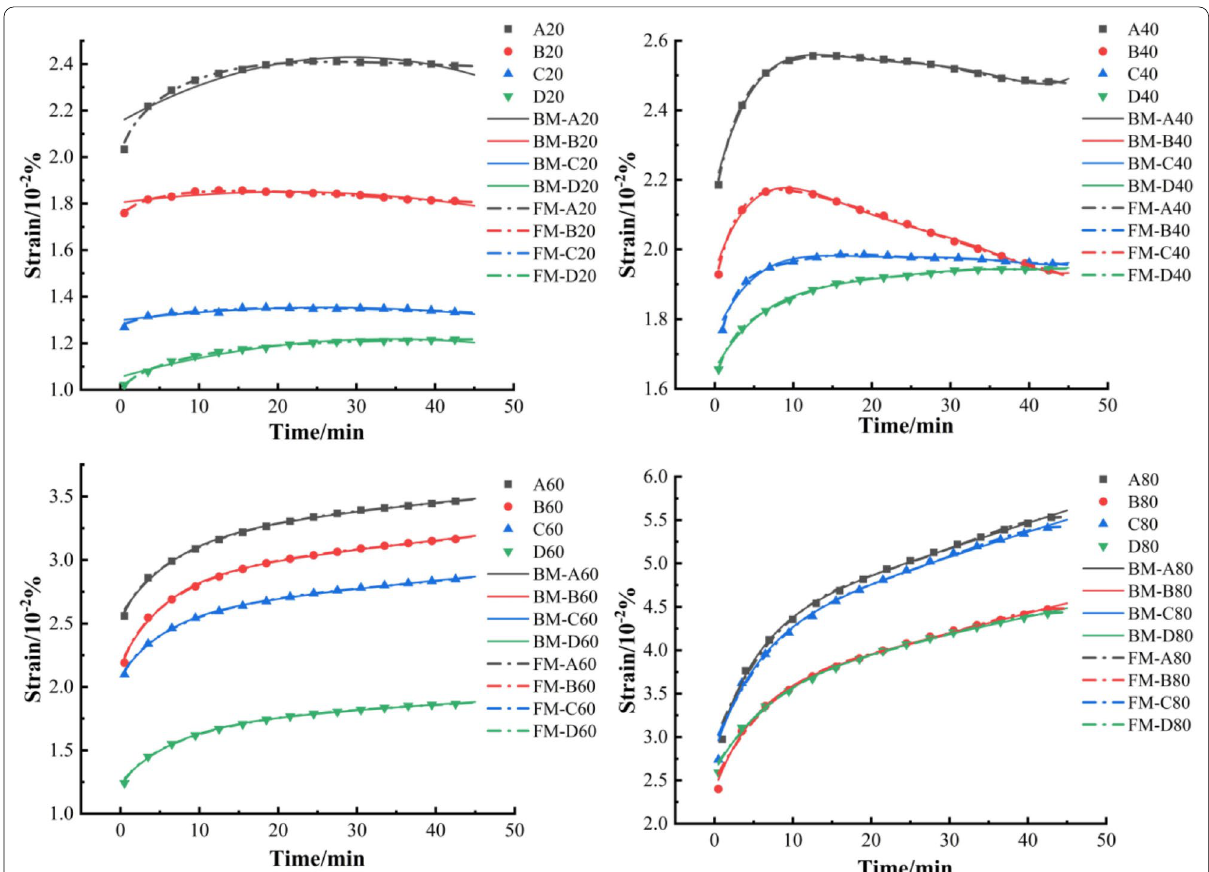
Fig. 9 Comparison between the model simulation and experimental points of white oak specimens with various distributions of earlywood vessel